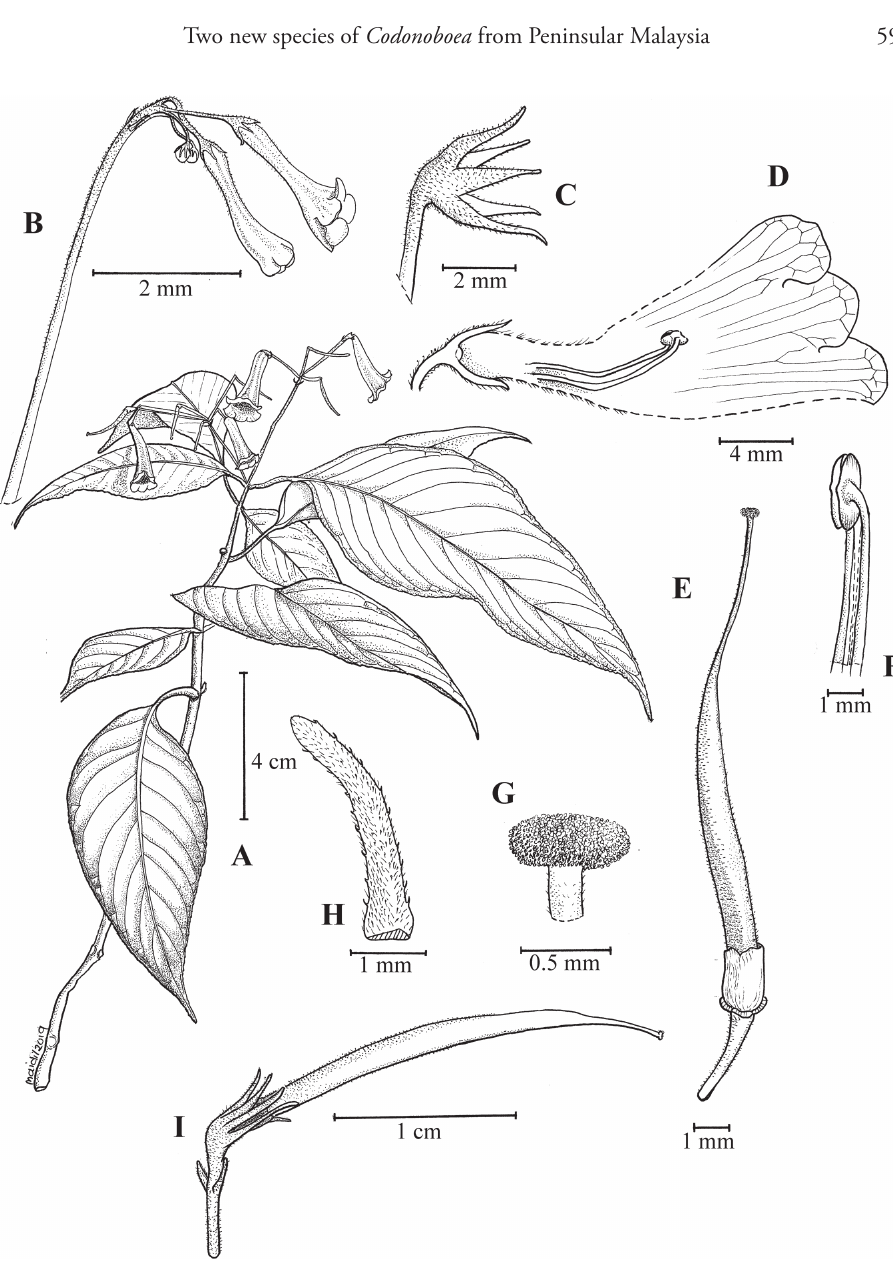
Figure 4. Illustration of Codonoboea ruthiae Syahida-Emiza, Y.Y.Sam & Siti-Munirah, sp. nov. A habit B inflorescence C calyx D flower opened to show position of stamens e pistil F anthers G stigma h bract I fruit (All from FRI 86960 , drawn by Mohamad Aidil